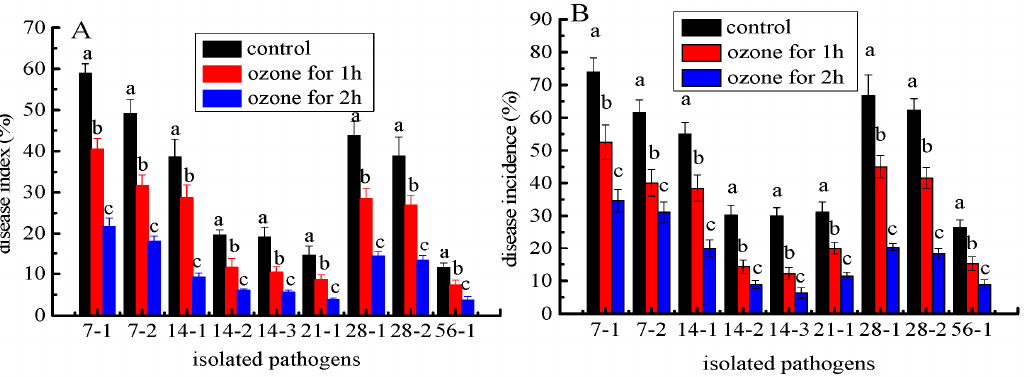
Figure 8. The effect of ozone treatment on disease index ( A ) and disease incidence ( B ) of fresh C. pilosula infected by the 9 isolates at 56 days of storage. (7-1: Actinomucor elegans ; 7-2: Mucor hiemalis ; 14-1: Fusarium acuminatum ; 14-2: Fusarium equiseti ; 14-3: Fusarium oxysporum ; 21-1: Clonostachys rosea ; 28-1: Penicillium expansum ; 28-2: Penicillium aurantiogriseum ; 56-1: Trichothecium roseum ). The differ- ent letters indicate significant differences during the same storage period ( p < 0.05